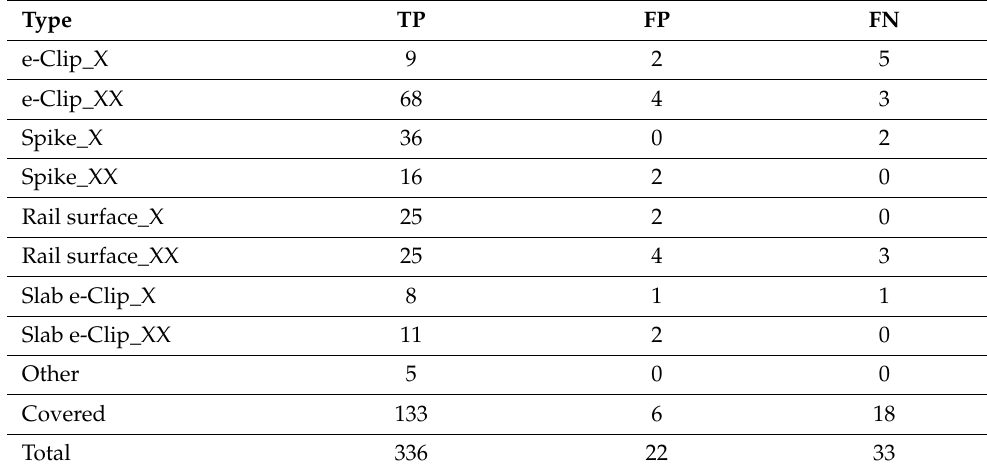
Table 9. YOLOv4 training results for each defective type in the top view.